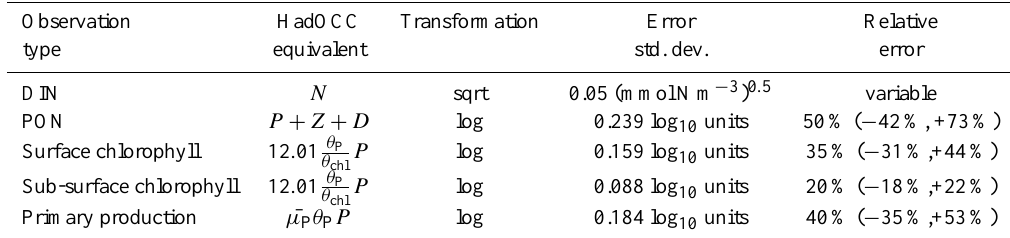
Table 3. Observation